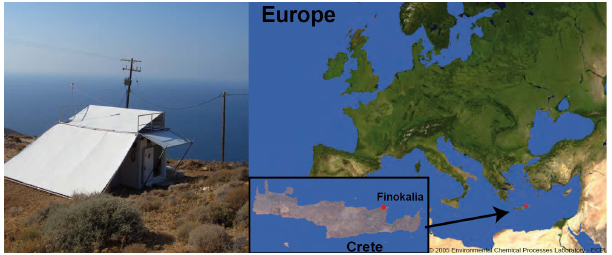
Fig. 1. Atmospheric aerosol measurements during ARIADNE: Container laboratory (left), and location of the Finokalia research site on Crete, in the eastern Mediterranean